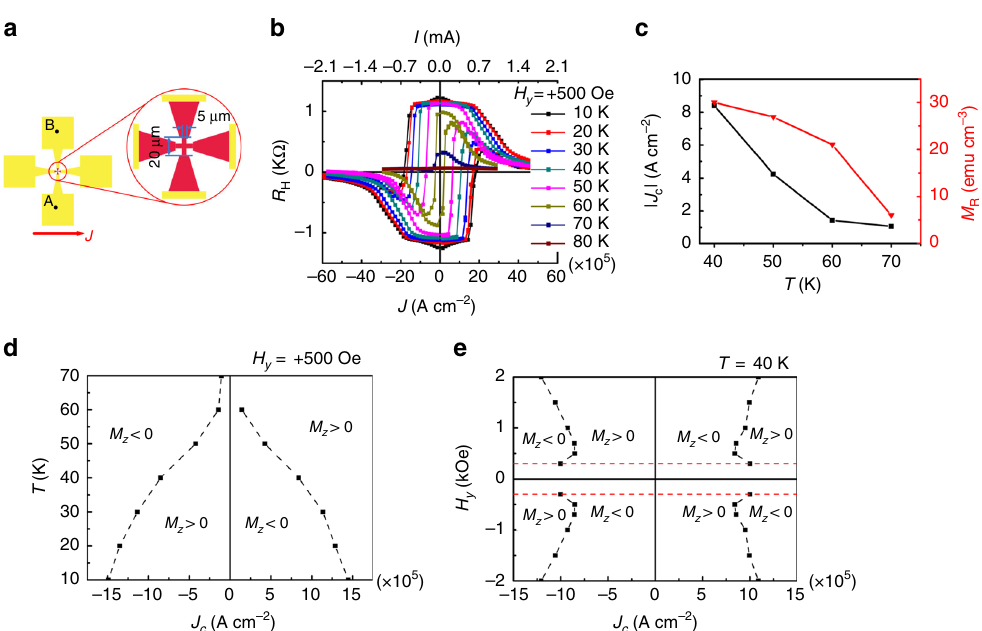
Fig. 3 Estimation of the heating effect and switching phase diagrams. a Schematic illustration of the device with Au (100 nm)/Cr (5 nm) electrodes as heat sinks. b SOT switching at various temperatures. c Temperature dependences of J c with an external magnetic fi eld ( H y ) of 500 Oe applied along the ½ (cid:1) 1 10 (cid:2) axis and remanent magnetization M R . d , e Switching phase diagram of the Ga 0.94 Mn 0.06 As thin fi lm about temperature ( T ) ( d ) and applied external magnetic fi eld ( H y ) along the ½ (cid:1) 1 10 (cid:2) axis ( e ). (Source data are provided as a Source Data fi le)